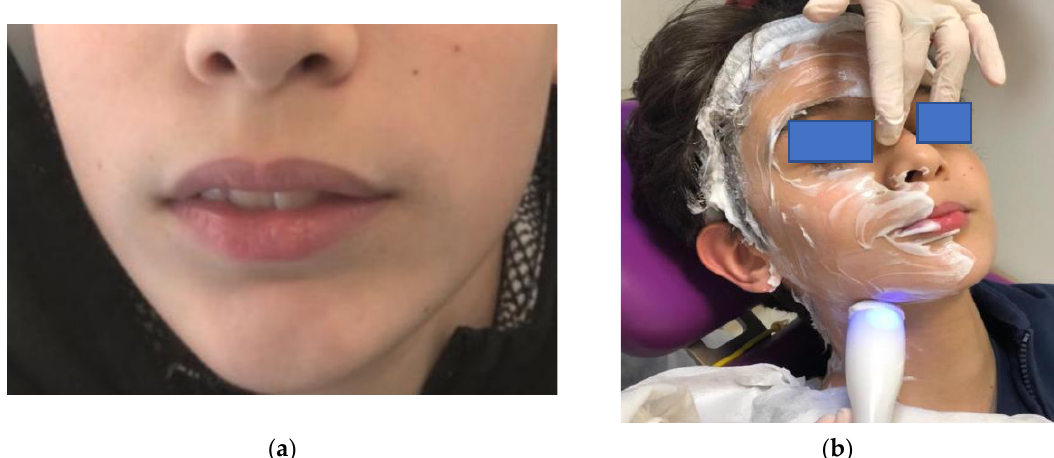
Figure 1. ( a ) Initial condition characterized by an extremely reduced masticatory function with a mouth opening of about 1 cm. ( b ) Application of cream with 80% aloe on face and neck and treatment with a dedicated intraoral handpiece (Velvet TMJ, Città di Castello, Italy).